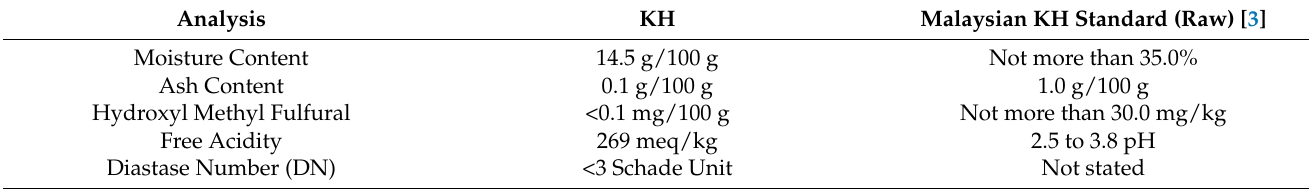
Table 3. Comparison of the physicochemical analysis of our KH and Malaysian KH Standard (Raw). Analysis